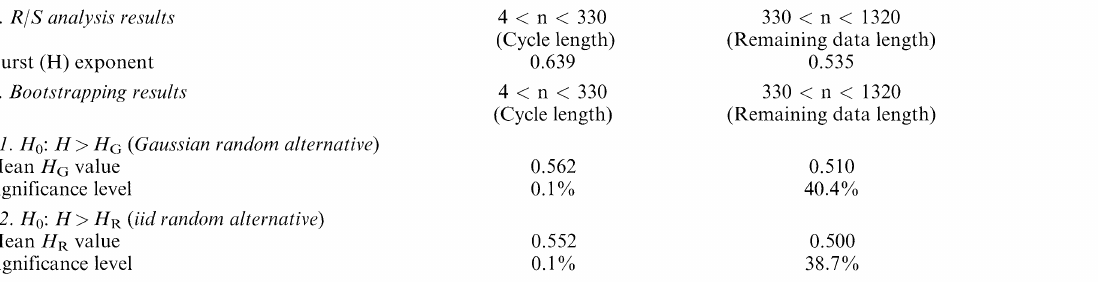
TABLE X The modified R/S statistic of the daily DM/GRD returns and bootstrapped critical values of the test statistic